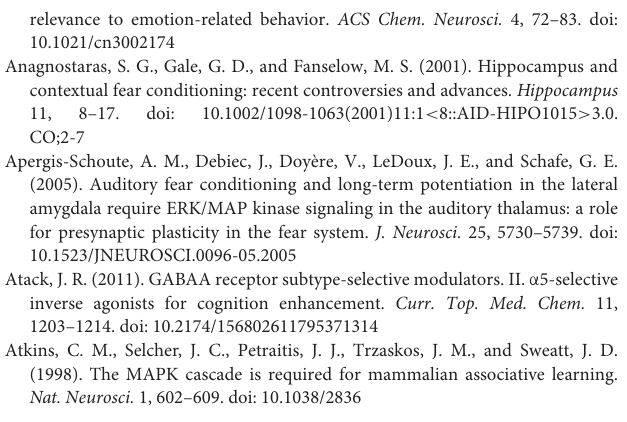
Figure S1 | HPLC-DAD-ESI/MS n analysis of the flavonoidic fraction (FfB) from the roots of Erythrina falcata using a C18 Luna column (A,B). TIC was performed in negative mode, and MS 2 spectra of deprotonated molecules (A) were obtained as follows: (1) vicenin-2 [M-H] − at m/z 593, (2) vicenin-1 [M-H] − at m/z 563, (3) vitexin [M-H] − at m/z 431, (4) isovitexin [M-H] − at m/z 431, (5) 6-C-glycoside diosmetin [M-H] − at m/z 461, and (6) apigenin [M-H] − at m/z 269. The chromatogram was recorded at 254nm for the UV spectra of compounds 1-6 (A)